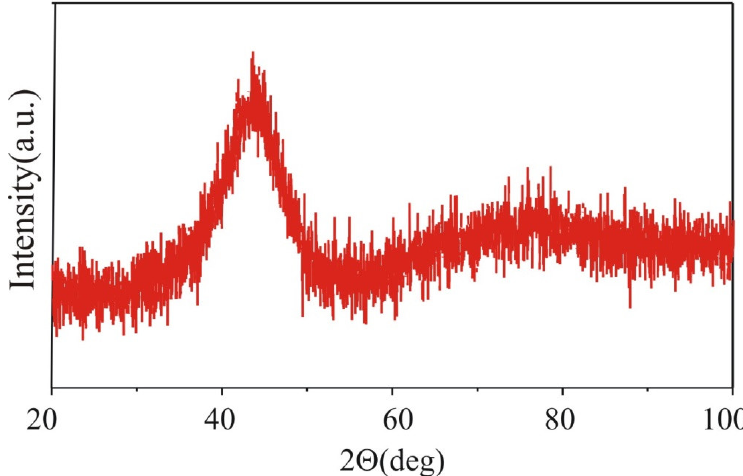
Figure 1. The X-ray pattern of the as-cast Fe 60 Co 12 Gd 4 Mo 3 B 21 alloy ribbon.